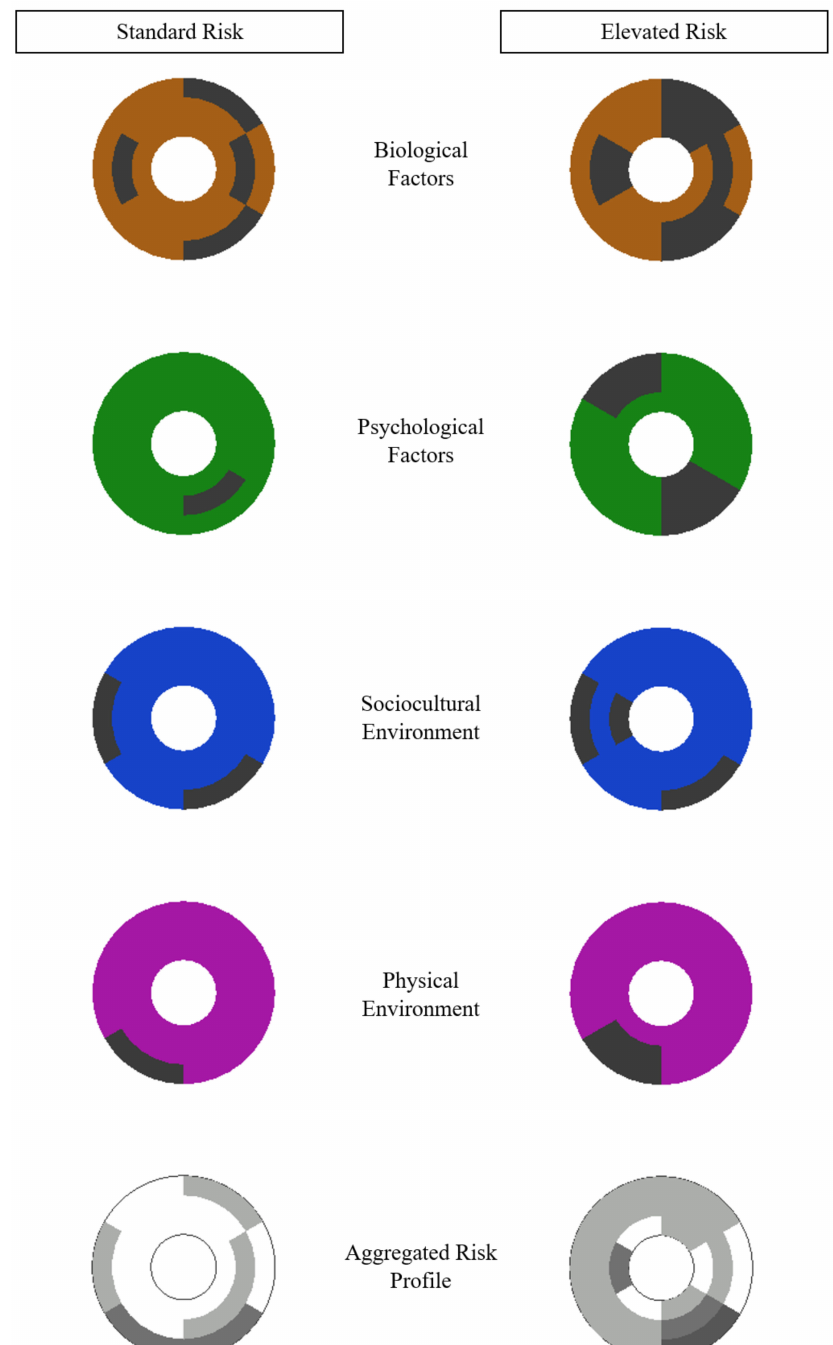
Figure 2. Top view of standard (left column) and elevated (right column) risk in the sport injury antecedents and consequences visualization template. Darkened areas indicate increased risk of